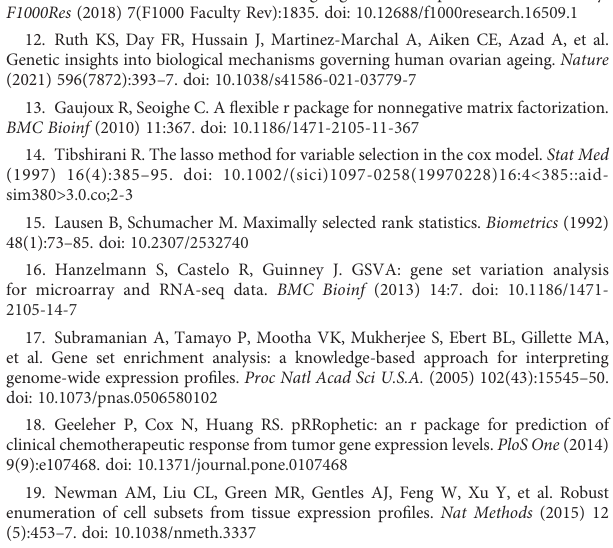
SUPPLEMENTARY FIGURE 6 Gene ontology (GO) and Gene set enrichment analysis (GSEA) functional enrichment analysis functional enrichment analysis of ovarian ageing-related gene (OARG) signature. GO functional enrichment analysis for (A) TCGA